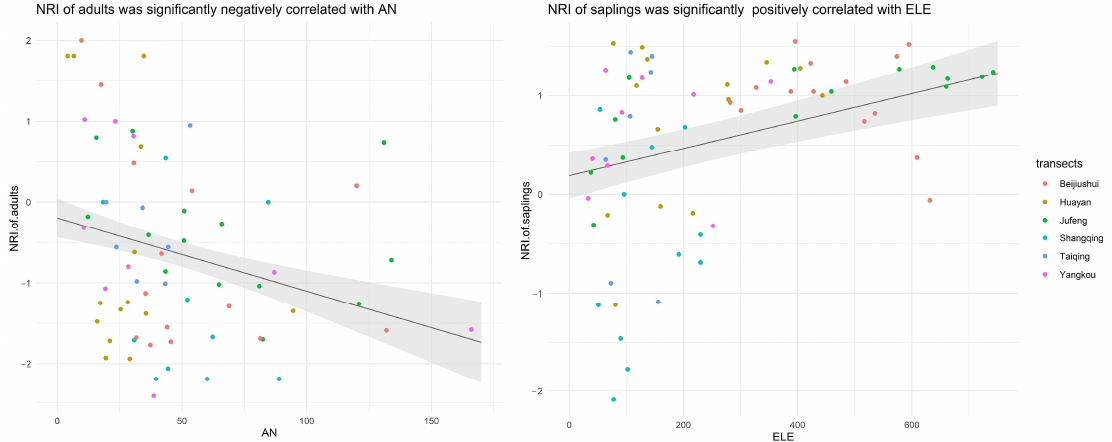
Figure 3. The results of linear mixed effect model of adult trees and saplings, respectively, taking transects as a random factor, net relatedness index ( NRI ) as a response variable, and ammonium nitrogen (AN, mg/kg) as an explanatory variables for adult trees; while taking net relatedness index ( NRI ) as a response variable and elevation (ELE, m) as an explanatory variables for saplings. The different colours represent the plots from different transects.